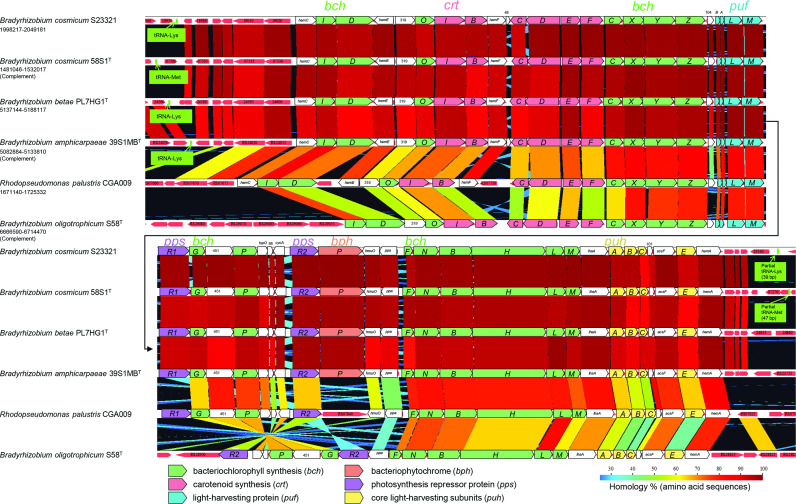
Comparative arrangement of the photosynthesis gene cluster (PGC) among 
Bradyrhizobium cosmicum
 58S1T and S23321, 
Bradyrhizobium betae
 PL7HG1T, 
Bradyrhizobium amphicarpaeae
 39S1MBT, 
Bradyrhizobium oligotrophicum
 S58T and 
Rhodopseudomonas palustris
 CGA009. Colour coding represents % homology based on amino acid sequences of PGC genes calculated by GenomeMatcher [35].